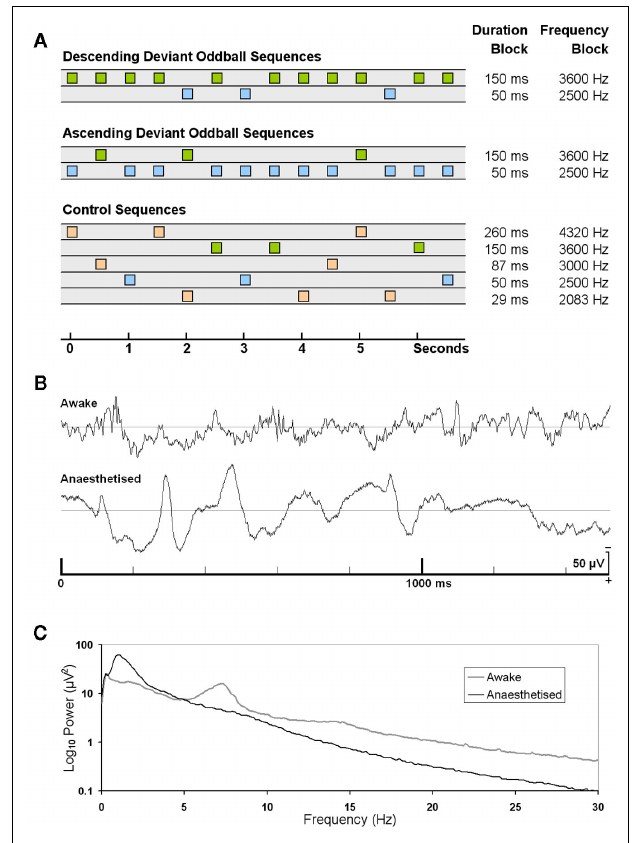
FIGURE 1 | (A) Schematic of the experimental design.There were three types of sequences: (i) descending oddball deviants (20%) in blue amongst high frequency/long duration standards in green, (ii) ascending oddball deviants (20%) in green among low frequency/short duration standards in blue, and (iii) control deviants (20%) with many standards (each 20% probability) in orange and stimuli equivalent to the deviant stimuli of the oddball sequences in blue and green.The SOA is 500ms. Columns on the right depict the frequencies and durations used in frequency and duration sequences respectively (modified from Maess et al., 2007). (B) 1.5s sample of epidural EEG in one animal in awake and anesthetized state. (C) EEG power spectra in the awake and anesthetized state. Computed using FFT of 10s Hanning windowed EEG epochs, averaged across all sessions from seven